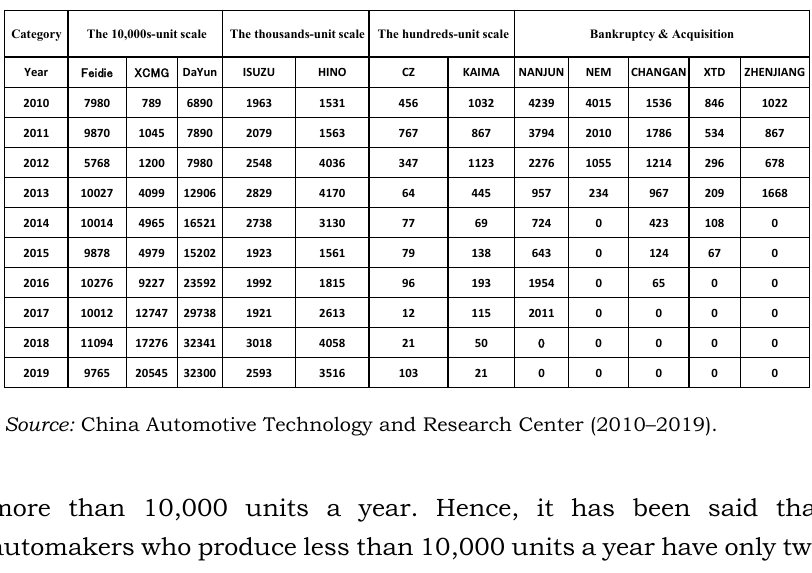
Table 1. Production volume of Chinese commercial vehicle makers (2010– 2019)